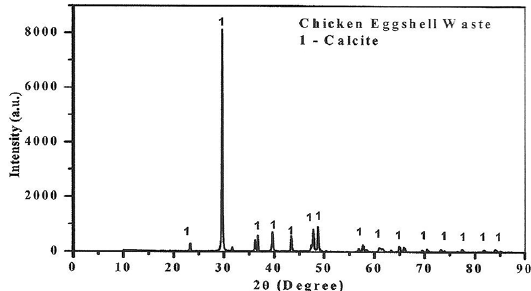
Figure 1. X-ray diffraction pattern of the eggshell waste